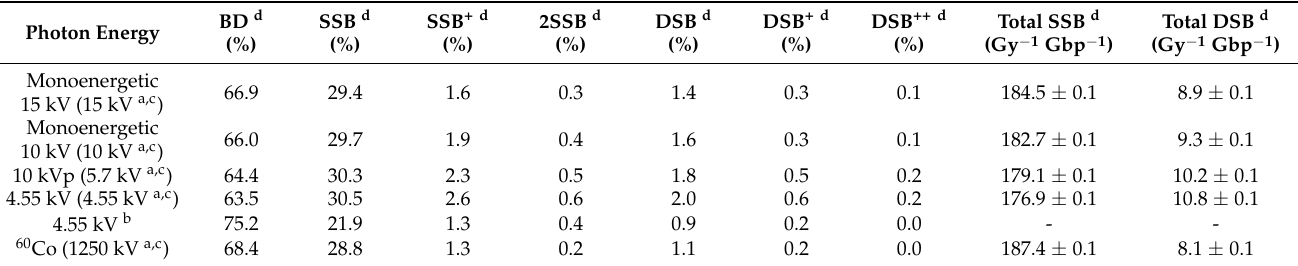
Table 2. Relative yield of DNA damage and absolute yields and the values for standard error of DSB and SSB (per Gy per Gbp) induced by X-rays and 60 Co γ -rays at a normal oxygen concentration (21%).